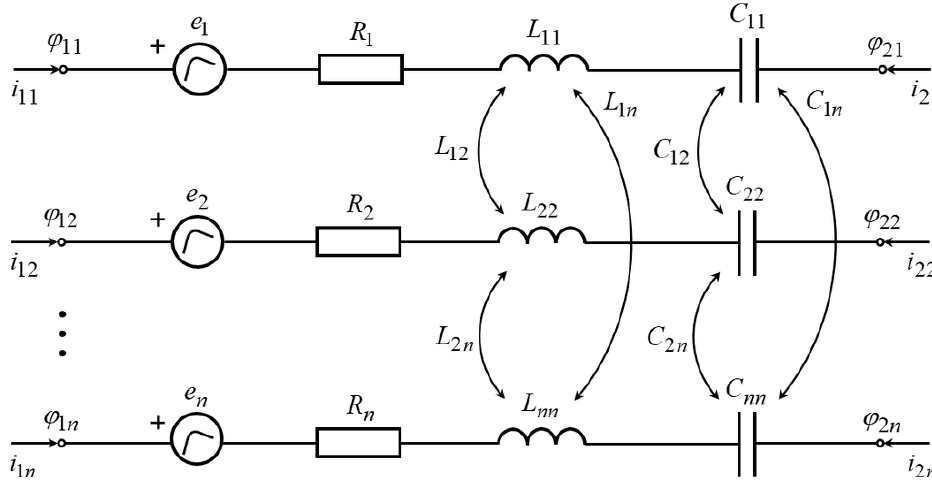
Figure 1. Coupled circuit finite element.